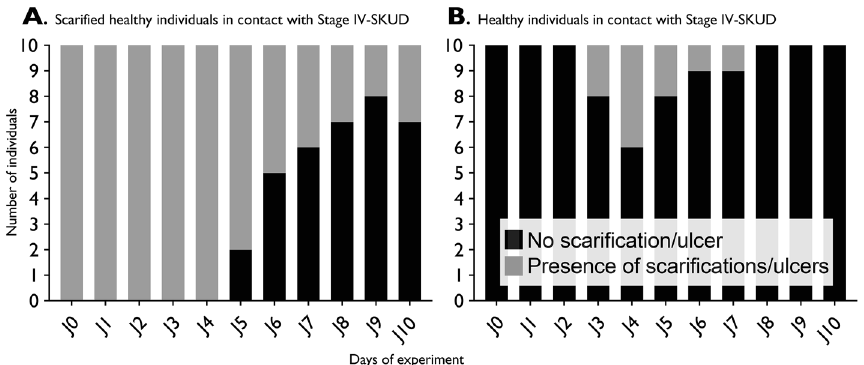
Figure 9. Attempted induction of SKUD in Holothuria scabra : qualitative pilot experiment performed to test a potential induction of the SKUD via a direct contact between healthy sea cucumbers and SKUD-affected sea cucumbers. ( A ) Inoculation of 10 scarified healthy individuals. ( B ) Inoculation of 10 non-scarified healthy individuals. Observations were performed for 10